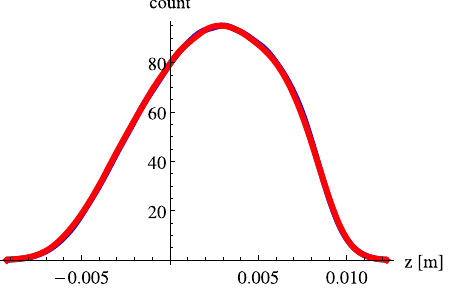
FIG. 1. Longitudinal distribution (collision off) obtained using ELEGANT and IBB considering the CEPC longitudinal impedance